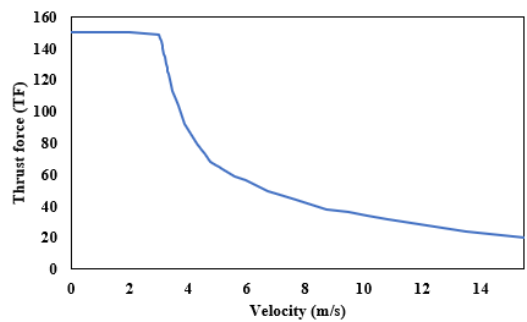
Figure 15. Thrust force at different velocities.